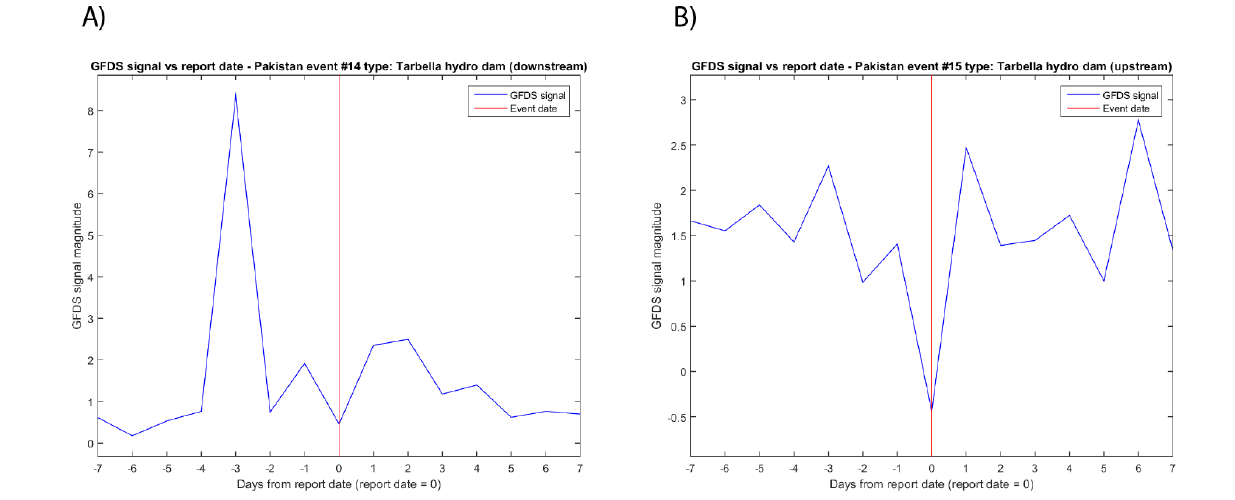
Figure 6. GFDS signal for locations directly ( A ) downstream and ( B ) upstream of the Tarbella Dam, in North-Eastern Pakistan.